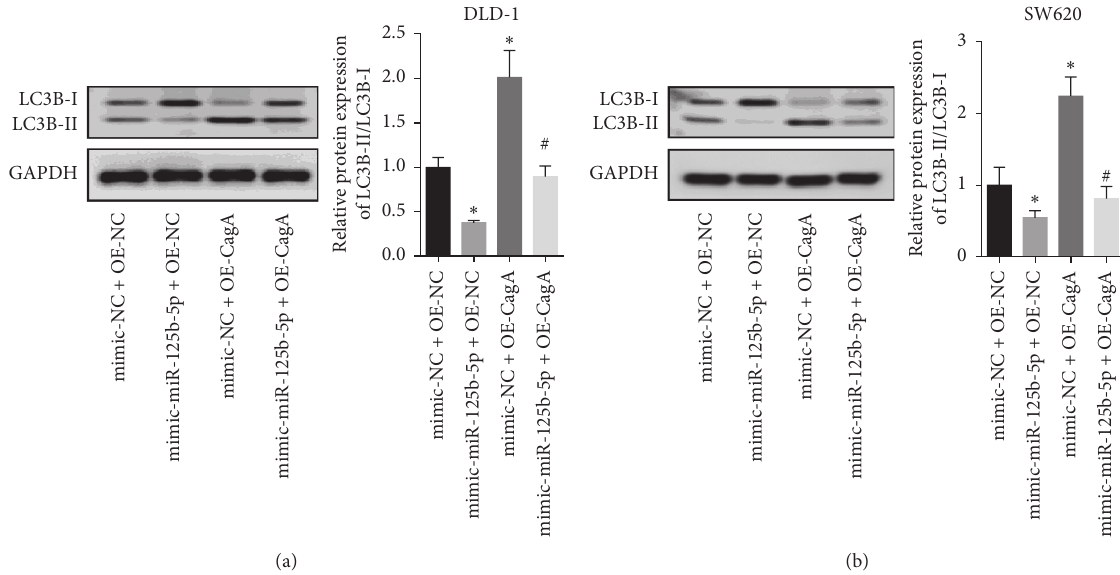
Figure 5: CagA overexpression promotes autophagy in colon cancer cells by inhibiting miR-125b-5p. (a) and (b) represent the transfection of CagA plasmid promoted, while transfection of miR-125b-5p inhibited the expression of LC3B-II/LC3B-I and reversed the effects of CagA on the expression of LC3B-II/LC3B-I in both DLD-1 (a) and SW620 (b) cells. ∗ p < 0 . 05, compared with mimic-NC+OE-NC, and # p < 0 . 05, compared with mimic-NC +OE-CagA